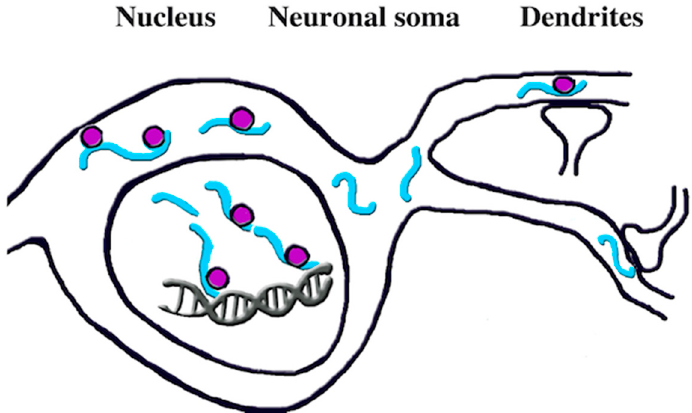
Figure 1. Pre-mRNAs-mRNAs conversion induced by NOVAs. The splicing occurs predominantly in the nucleus where spliceosome complexes (red spheres) bind to YCAY motifs and remove introns from growing pre-mRNAs (co-transcriptional process). Further splicing takes place in the cytoplasm (including dendrites near synapses), with spliceosomes operative on pre-mRNAs (pre-translation process), making possible their subsequent translation. The long blue filaments are pre-mRNAs, the shorter filaments are the results of ongoing or complete conversion into mRNAs. (details from Ref. [24]).